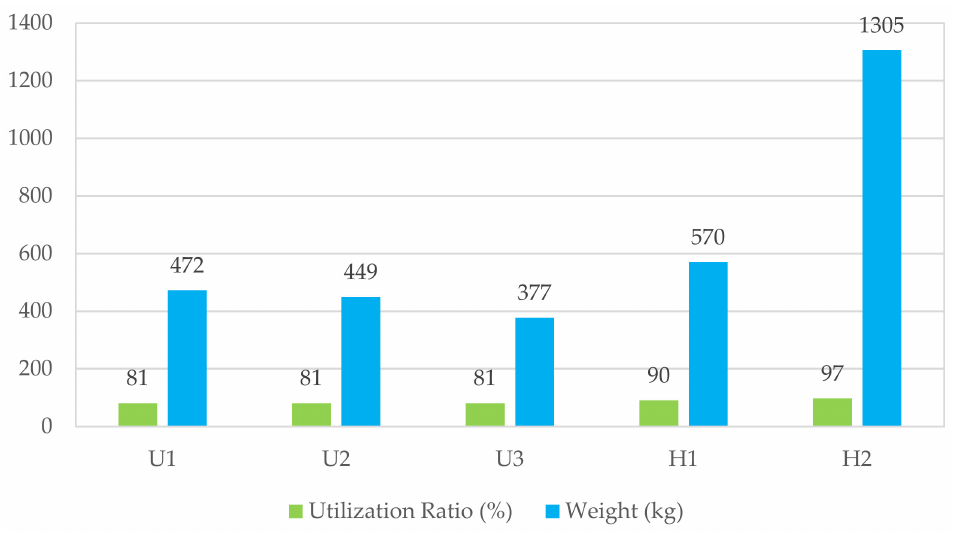
Figure 29. Comparison of utilization ratios of EW having various PSSs and weight of